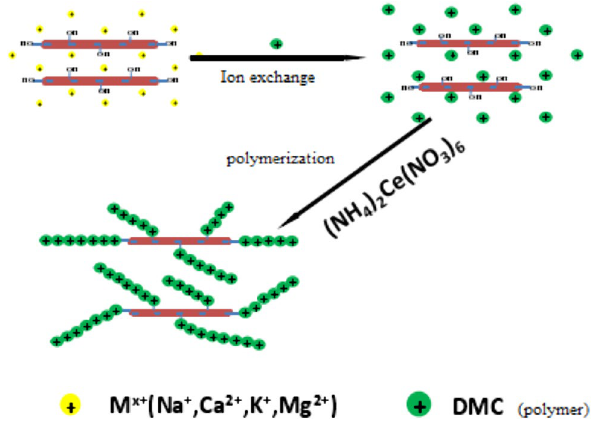
Fig. 3 Flowchart of bentonite modified by cationic